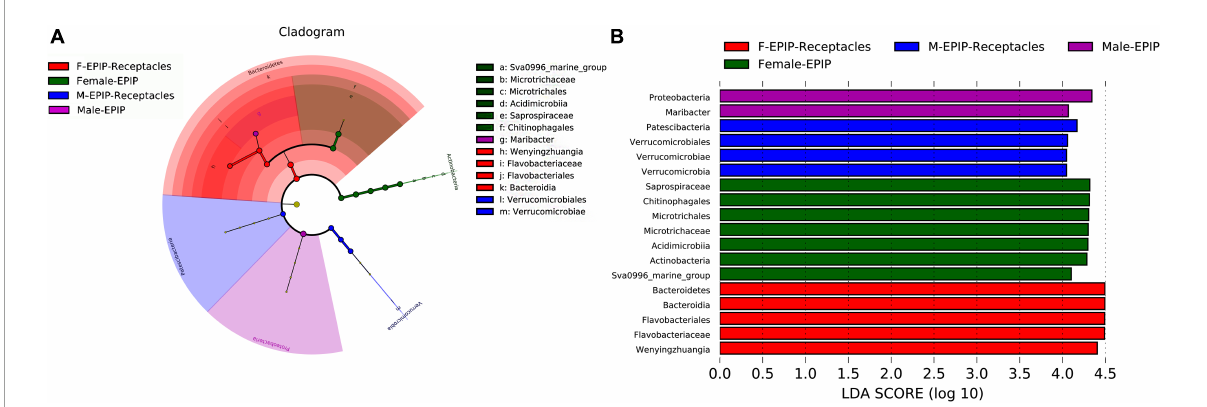
FIGURE5 Indicator species analysis of algal bodies and receptacles of male and female S. thunbergii . The cladogram shows the phylogenetic structures of the microbiota. In the branching diagram of their evolution, the circles that radiate from inside to outside represent taxonomic levels from phylum to genus, and each small circle represents an individual taxon. The diameter of the circles is proportional to the relative abundance. The linear discriminant analysis (LDA) scores indicate significant differences in bacterial taxa (LDA score > 4.0). (A) Cladogram. (B) LDA score